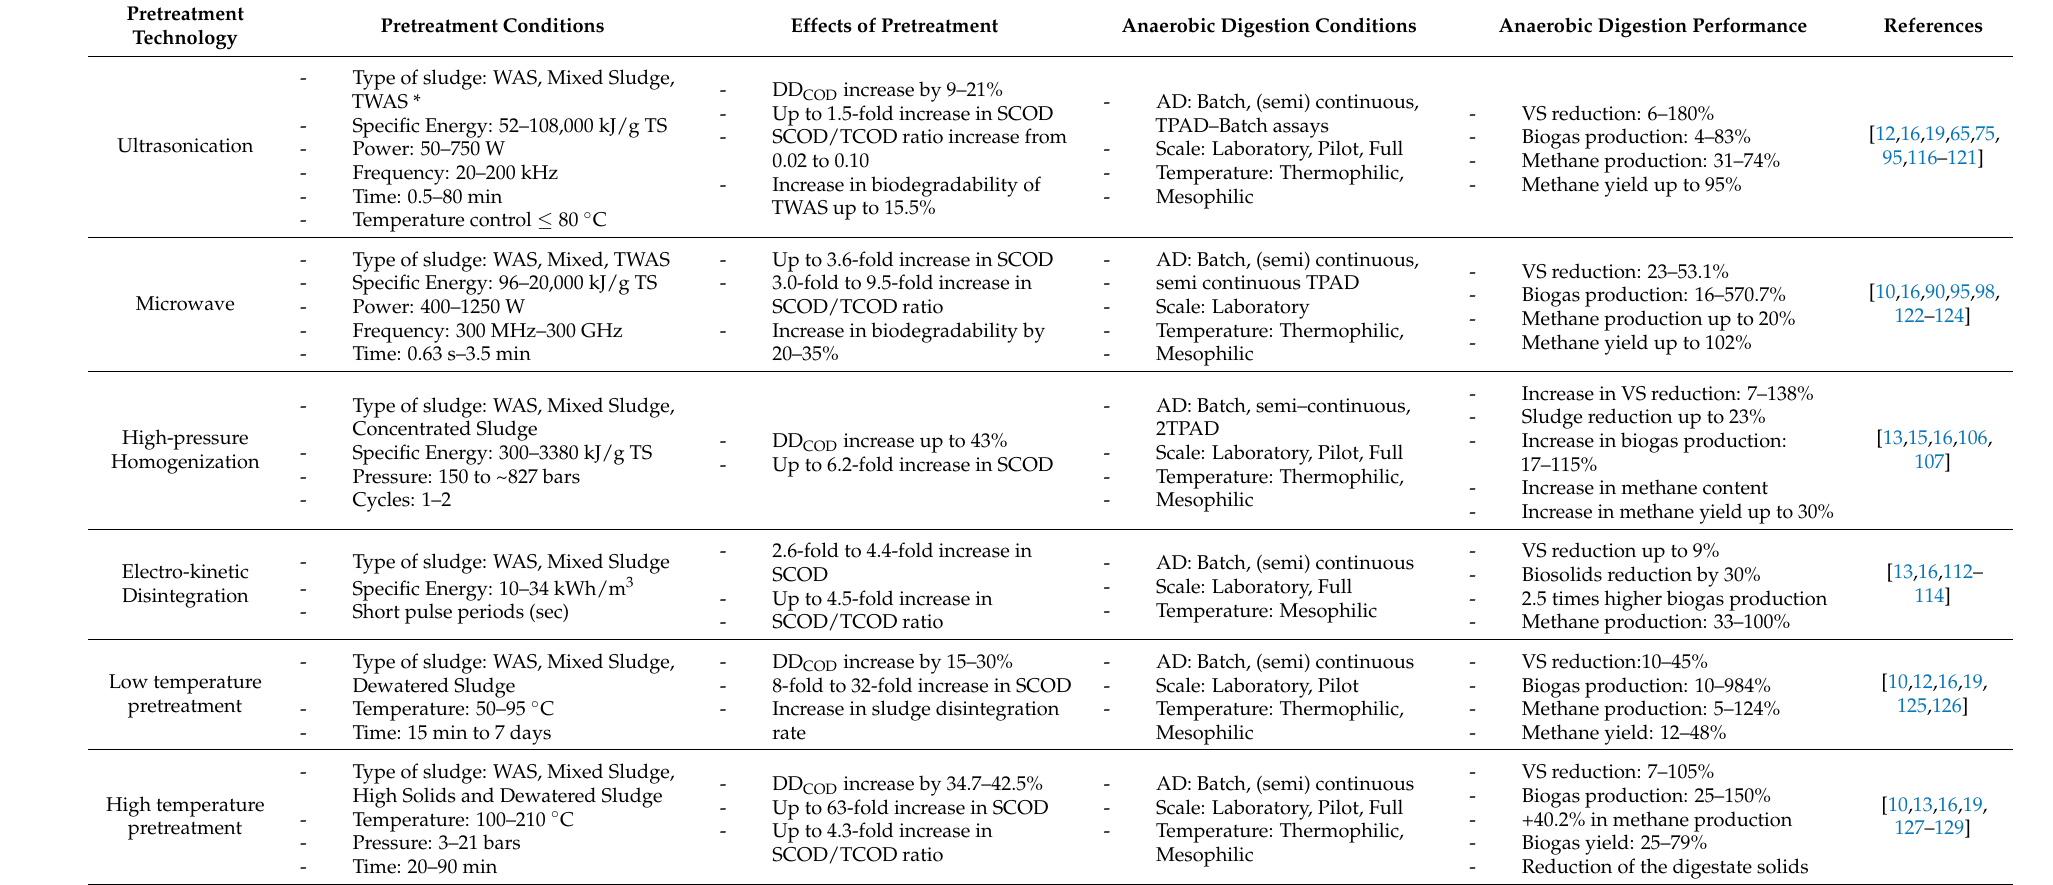
Table 2. Effects of physical/mechanical and thermal pretreatment methods on anaerobic